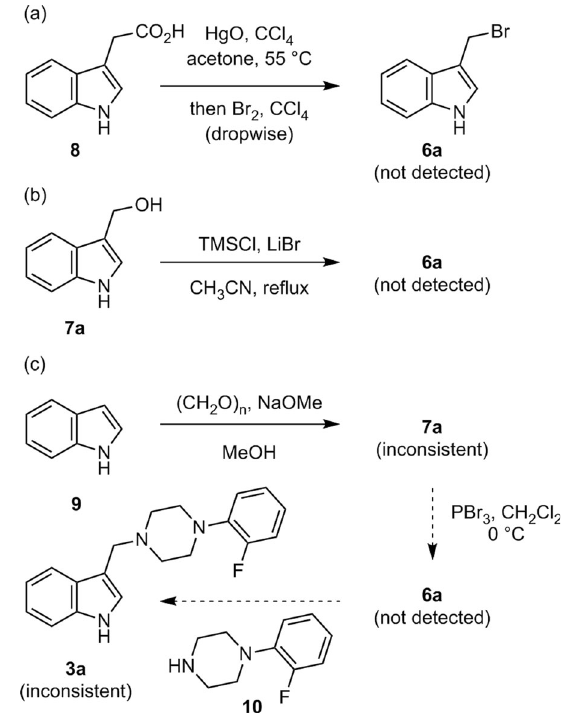
Fig. 2 Examination of previously reported syntheses of (1 H -indol-3-yl) methyl bromide (6a) and its derivatizations. a Preparation of 6a via the Borodin – Hunsdiecker reaction reported by Eryshev et al. b Preparation of 6a via bromination with TMSCl and LiBr reported by Scanlan et al. c Preparation of 6a via bromination with PBr 3 reported by Mekonnen Sanka et